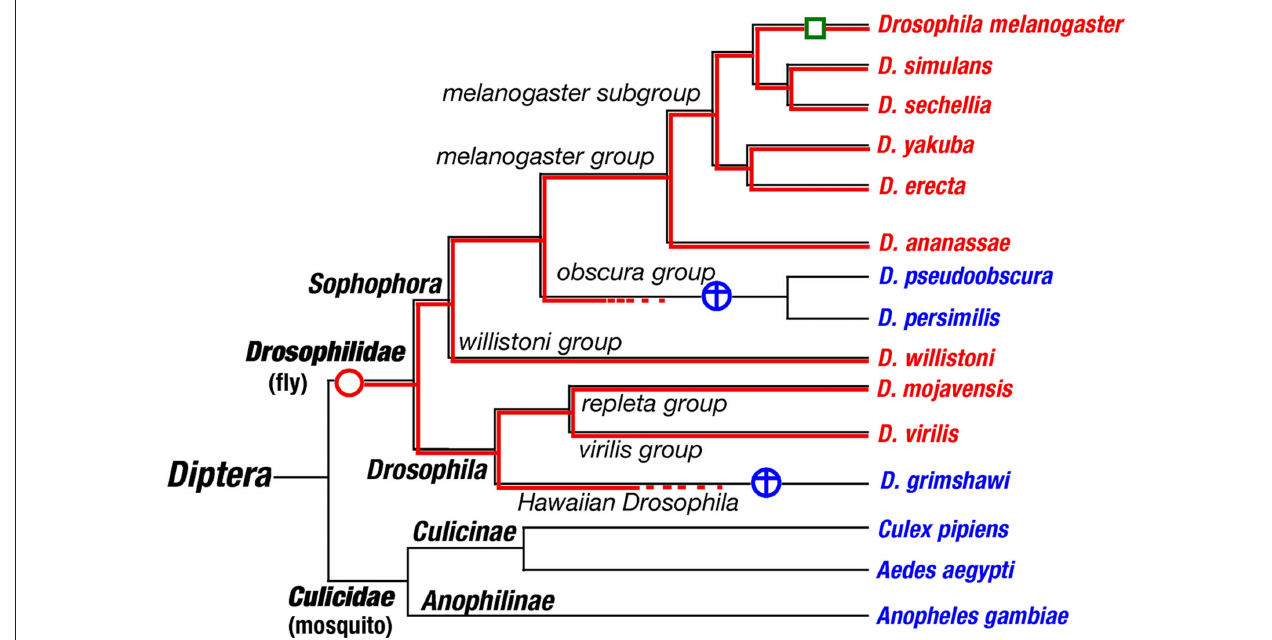
names in red and blue italics illustrate species with or without Gr5a orthologs, respectively. Red and blue circles represent gain and loss events of Gr5a orthologs, respectively. A green box represents a functional mutation from ancestral Thr 218 to Ala 218 that occurred only in Drosophila melanogaster